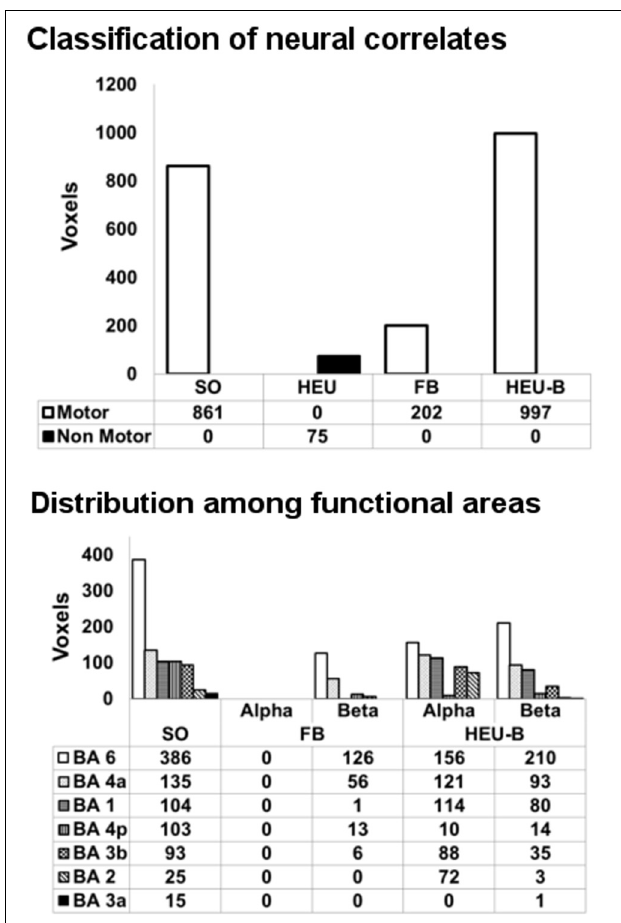
FIGURE 4 | Classification of neural correlates from single model mapping. Top panel: voxels classification according to the BAM (voxels belonging to the same areas activated in SO analysis are classified as “motor” voxels). Bottom panel: distribution of “motor” voxels among the Brodmann areas identified by the SO analysis. Since HEU model only produced “non motor” voxels, it was not included in this second classification. The number of voxels assigned to the classes are tabulated below bars.